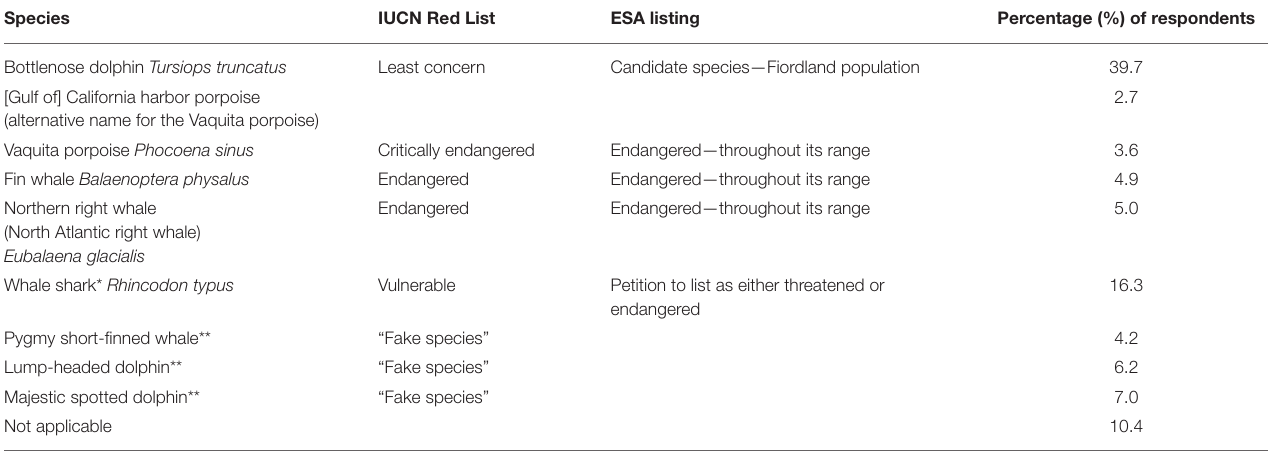
TABLE 5 | Percentage of respondents whom felt the listed dolphin/whale species was the most important to conserve along with the IUCN Red List and US Endangered Species Act (ESA) listing for each species ( n =